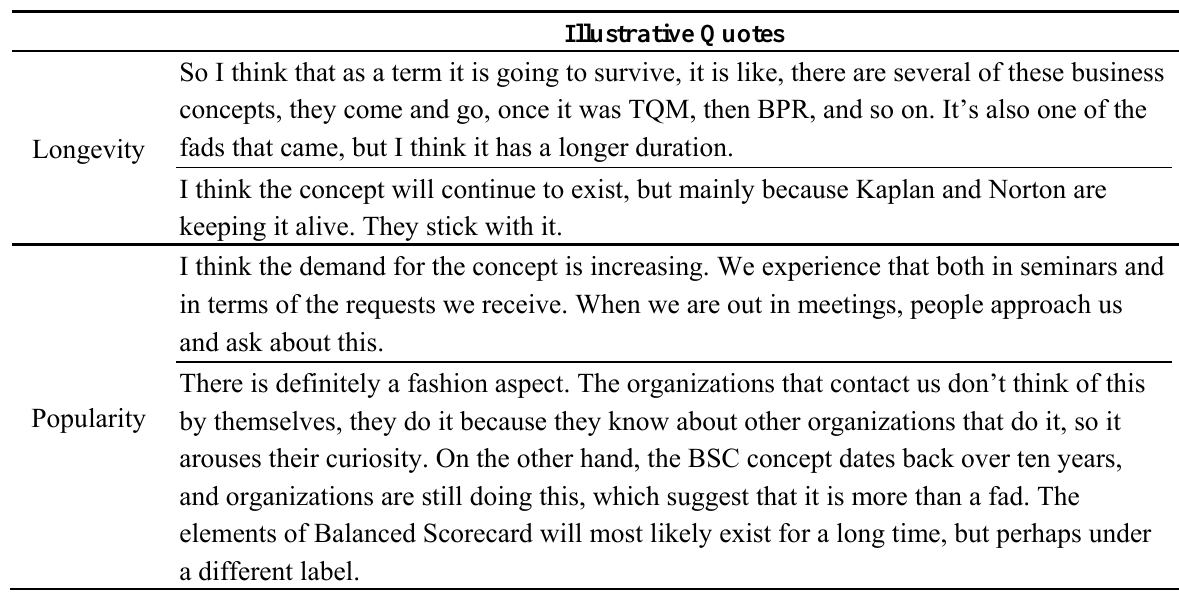
Table 5. The life cycle of the